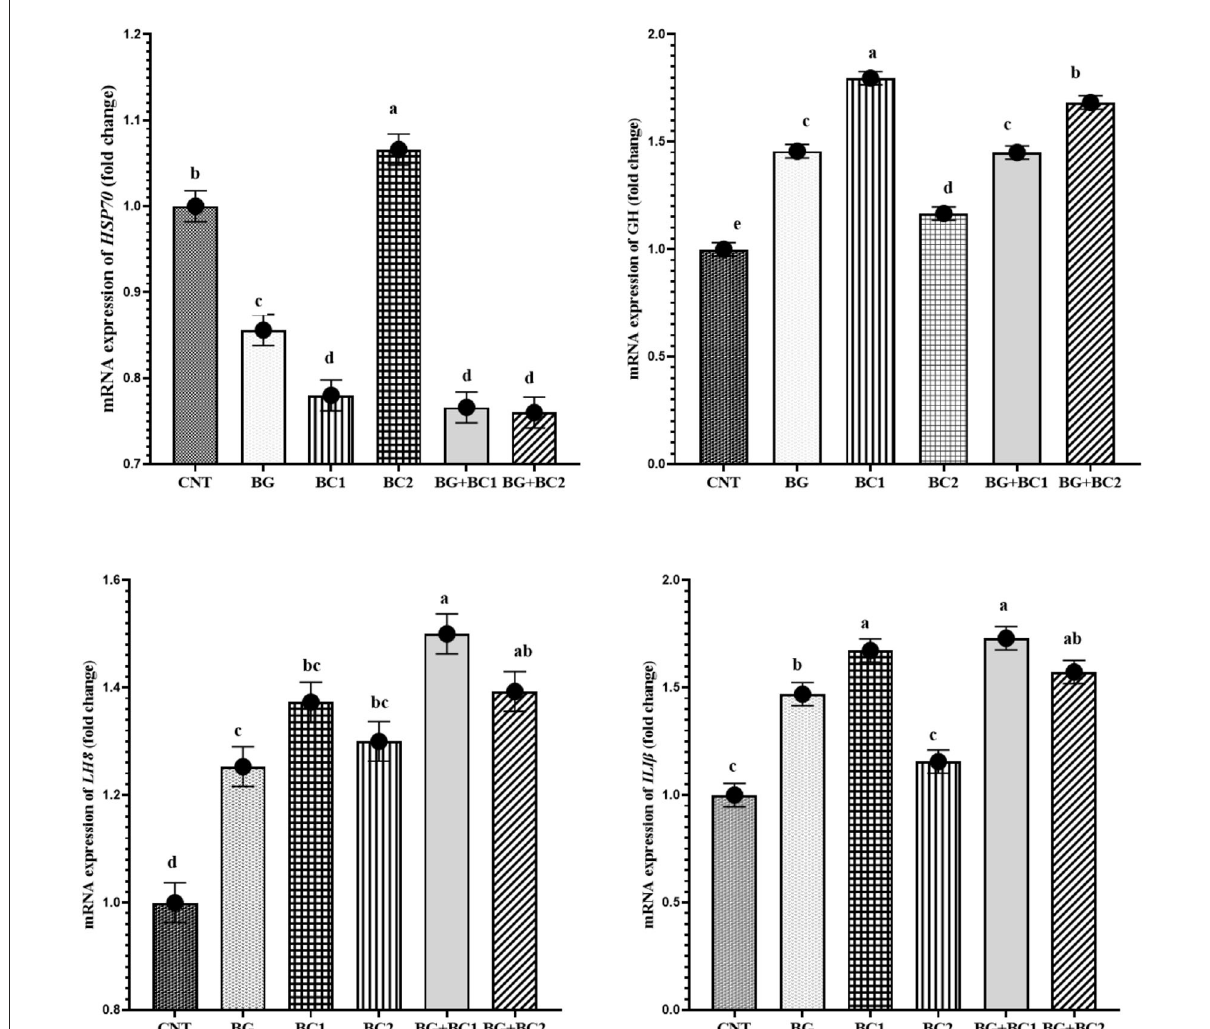
FIGURE2 mRNA expression levels of heat shock protein -70 ( HSP70 ), growth hormone ( GH ), interleukin-1 beta ( IL-I β ) and interleukin-8 ( IL-8 ) genes in the liver tissue of Nile tilapia, Oreochromis niloticus (mean ± MSE) fed on diets supplemented with graded levels of β -glucan and/or Bacillus coagulans for 14 weeks. Columns with different superscribt letters are significantly different ( P < 0.05